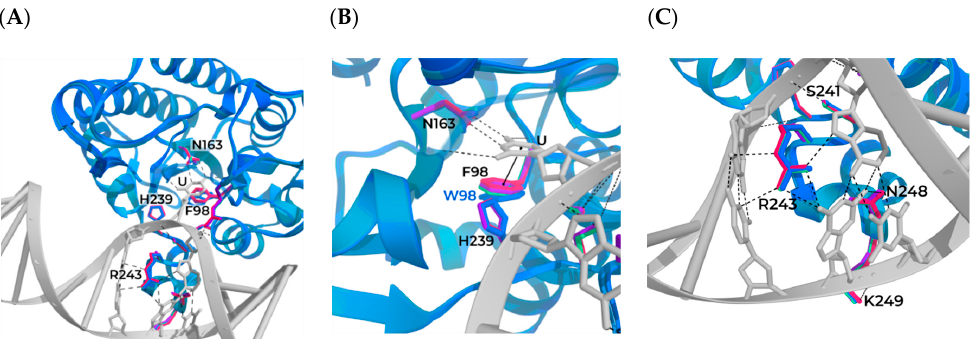
Figure 4. Structural alignment of WT hSMUG1 and of mutants. ( A ) Superposition of WT hSMUG1 (magenta), F98W (blue), H239A (cyan), and R243A (violet) structures in complex with DNA. Close-up view of the locations of Phe98 and His239 ( B ) and hydrogen bonds formed by Arg243 with DNA ( C ) in the active site of the enzyme. Direct contacts are shown as dashed black